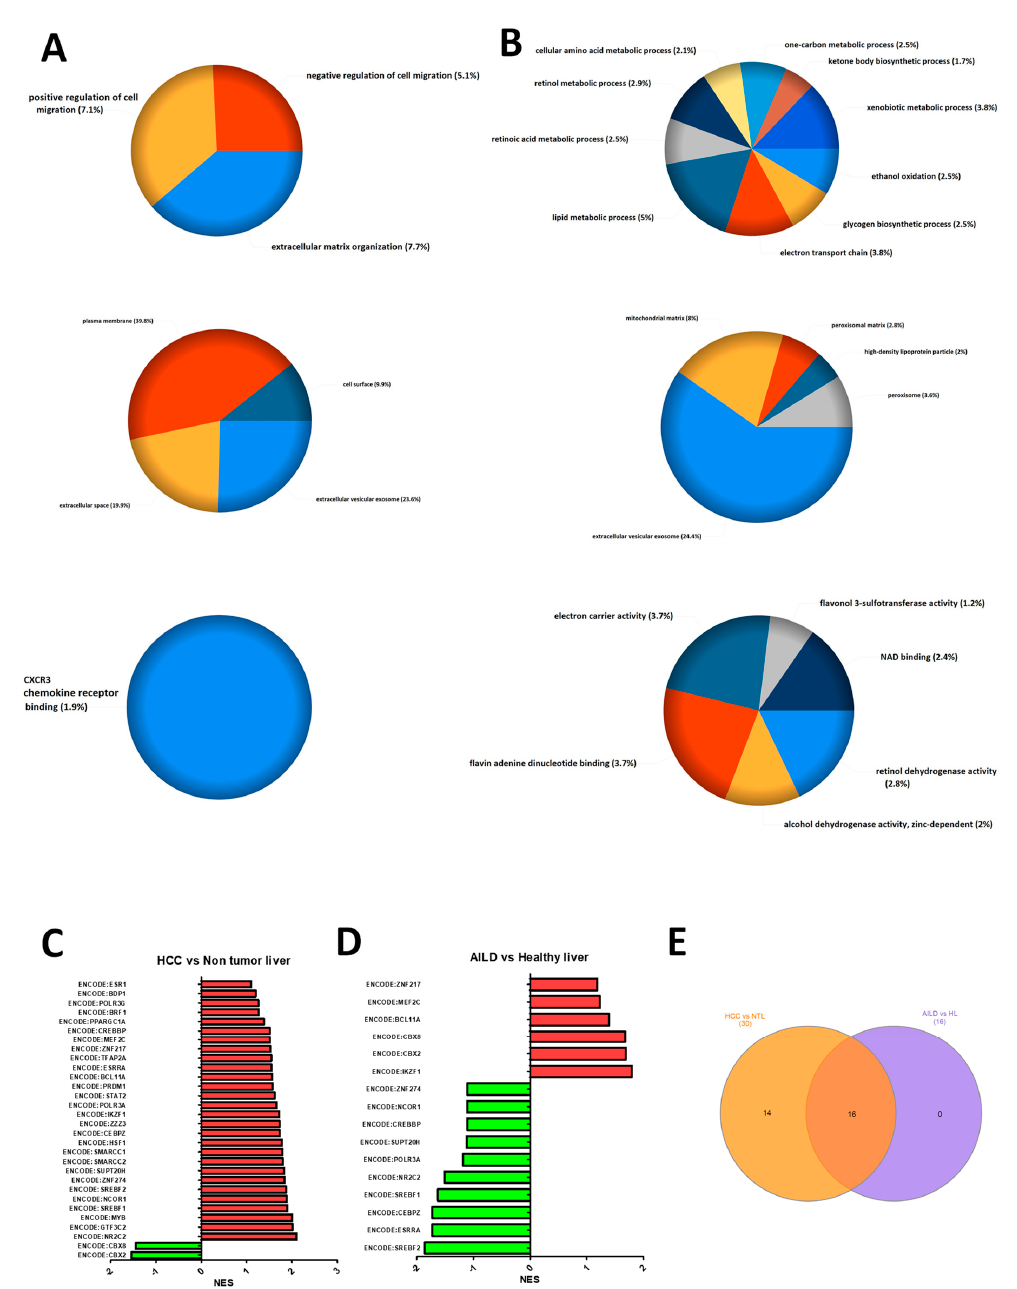
Figure 2. Extensive cellular reprogramming governs progression towards HCC as well as AILDs. ( A , B ) gene ontology enrichment analysis with common upregulated ( A ) and common downregulated ( B ) genes between AILDs (GSE159676) and HCC (GSE62232) with respect to healthy/non tumor liver. Panels from top to bottom represent enrichment plots against the GO biological process, GO cellular compartment and GO molecular function, respectively. Analysis and pie chart construction were performed on FunRich v3.1.4. ( C , D ) bar plots showing NES of gene set enrichment analysis between AILD vs. healthy liver ( C ) and HCC vs. non tumor liver ( D ) against “TF.Target.ENCODE” database (the green and red colored bars indicate downregulated and upregulated gene sets, respectively). ( E ) Venn diagram presenting the common transcription factor modules (total 16 modules as shown in the overlapping region) enriched in the two comparisons. Orange circle indicates HCC vs. NTL (non tumor liver) and purple circle indicates AILD vs. HL (healthy